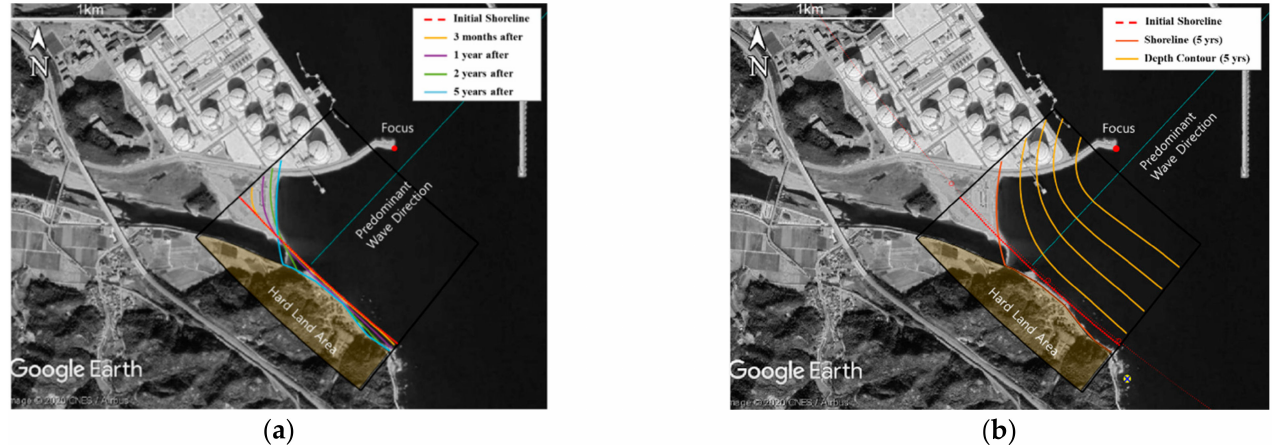
Figure 16. Shoreline change model simulation of change that construction of Samcheok LNG Plant caused to Wolcheon beach: ( a ) shoreline change; ( b ) depth contour change (image from Google Earth as at November 2019).